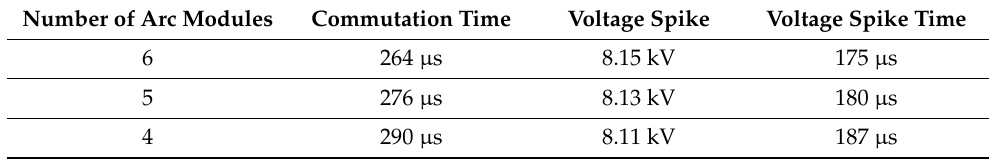
Table 2. The simulation results of the different numbers of arc modules. Number of Arc